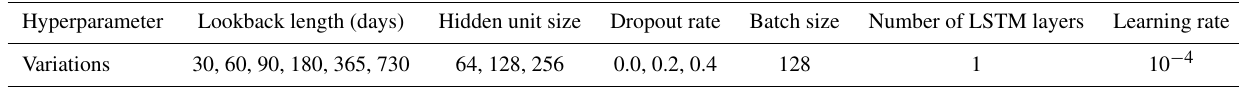
Table 2. The hyperparameters tested for all LSTMs in the paper and their variations.